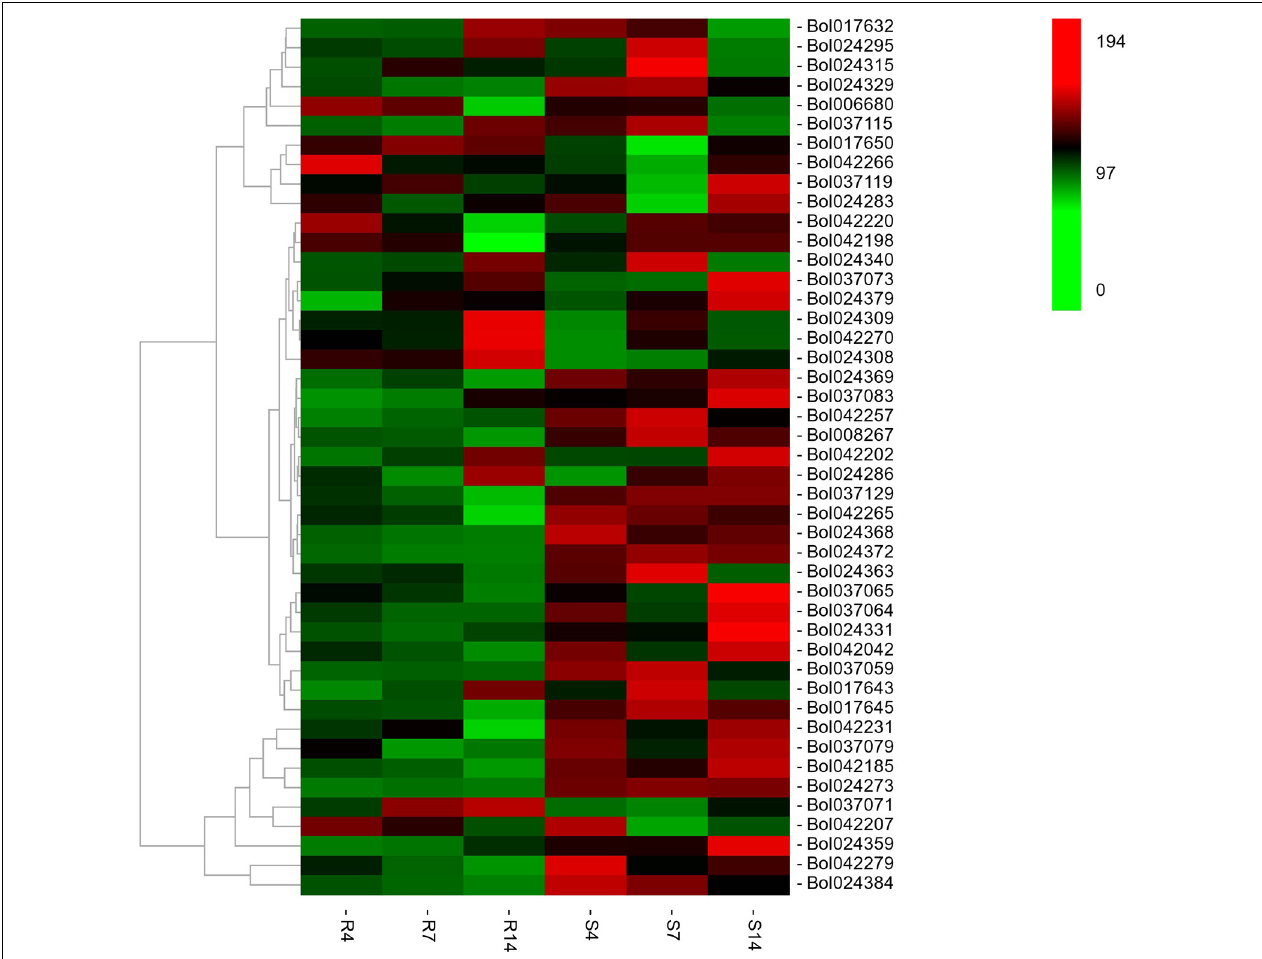
FIGURE 3 | The heatmap analysis of the expression of 46 differentially expressed genes (DEGs) underlying the CIs of qCRc4-1, qCRc7-2, qCRc7-3, and qCRc7-4 . The average expression values of genes in different inoculation times were denoted at the right with a color scale, in which green, black, and red color indicated the low, medium, and high level of expression,